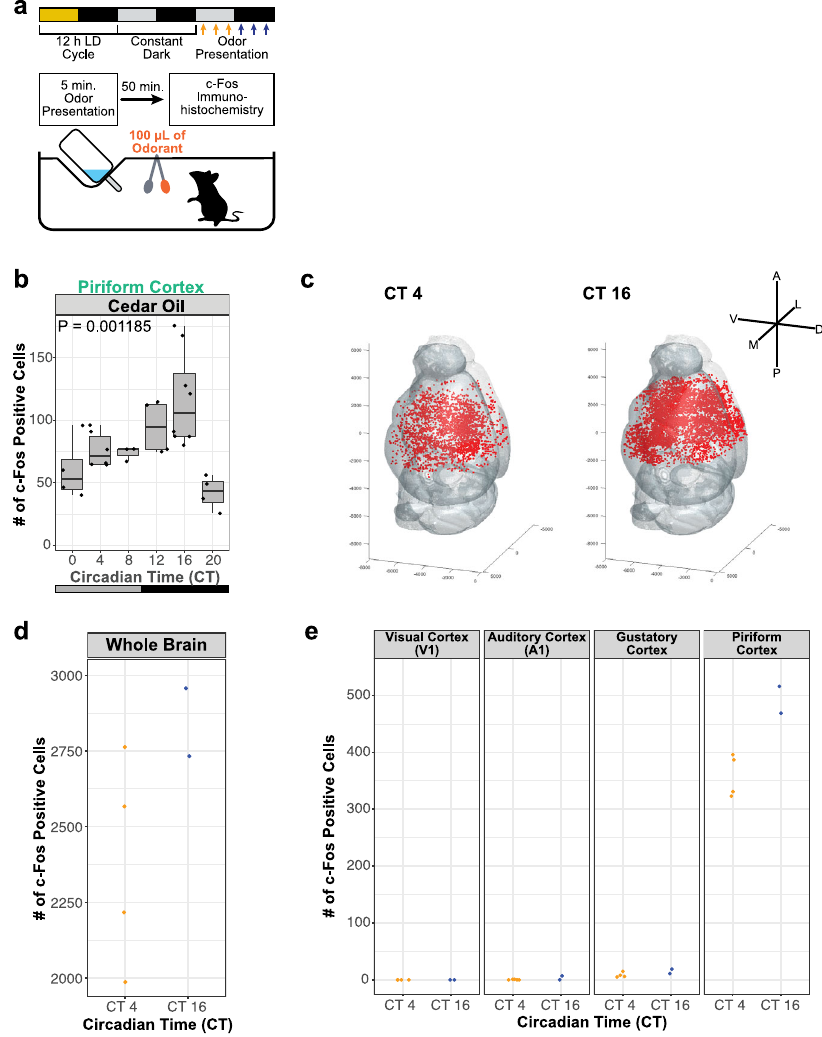
Fig. 1 Circadian rhythms of neural activity are most evident in the PC. a Schematic illustration of the odor-presentation experiment for c-Fos quanti fi cation. 100 µ L of cedar oil (1:1000 dilution in paraf fi n oil) was presented at six different timepoints for 5 min. b The number of c-Fos positive cells in the PC of mice exposed to the odor at six timepoints (CT0, 4, 8, 12, 16, 20). N = 4, 6, 3, 4, 8, 4 for CT0, CT4, CT8, CT12, CT16, CT20, respectively. p = 0.001185, one-way ANOVA. The line at the center of each boxplot depicts the median; the box depicts the third quartile and fi rst quartile. c Representative whole-brain reconstruction of c-Fos positive cells in mice that were kept in home cages and then sacri fi ced at two timepoints (CT4, CT16). Red dots indicate individual c-Fos positive cells. d Quanti fi cation of the number of c-Fos positive cells in the whole brain. N = 4 and 2 for CT4 and CT16, respectively. e The number of c-Fos positive cells in fi ve sensory cortical areas: visual cortex (V1), auditory cortex (A1), gustatory cortex, and PC in mice that were kept in home cages and then sacri fi ced at two timepoints (CT4, CT16). N = 4 and 2 for CT4 and CT16,